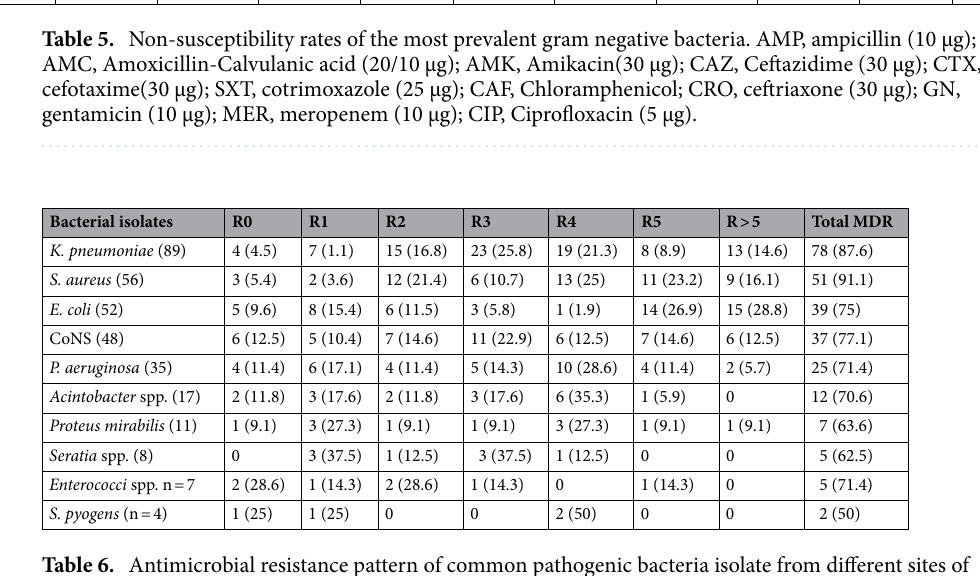
Table 6. Antimicrobial resistance pattern of common pathogenic bacteria isolate from different sites of infections. R0: susceptible to all antimicrobials tested; R1, R2, R3, R4, R5, R > 5: Resistance to one, two, three, four, five, and more than five antimicrobials,